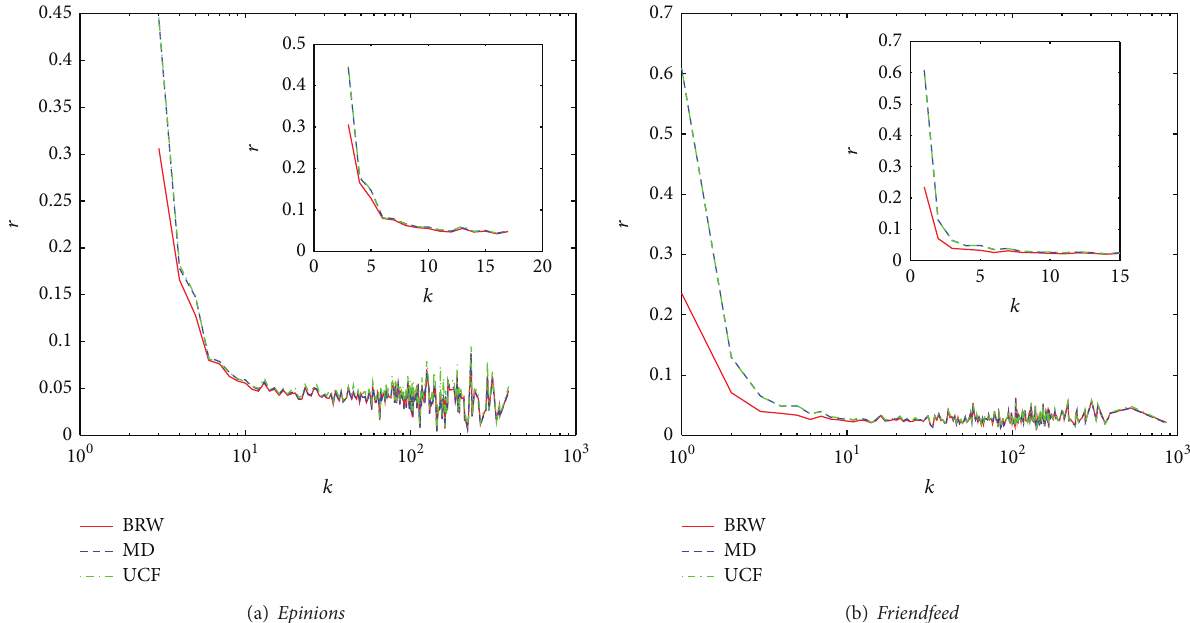
Figure 5: Ranking score values venus degree 𝑘 on Epinions and Friendfeed data sets (color online). The red line, blue line, and green line indicate the performance of BRW, MD, and UCF, respectively. The inset figure amplifies that ranking score versus the degree of users from 1 to